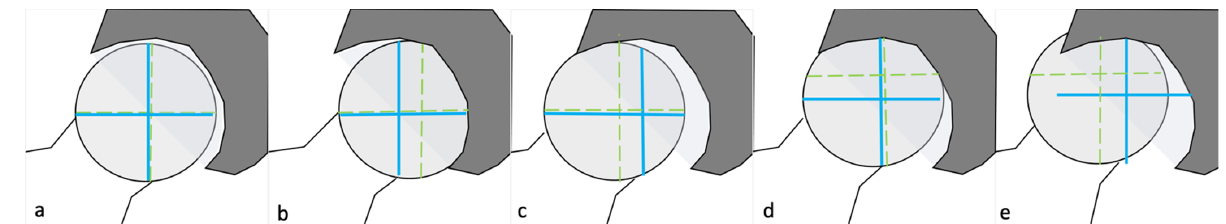
Figure 4. Hip deformities. Five types of hip deformities are shown, adapted from Kase et al. [11]. On each scheme, the femoral head is colored in grey, the acetabulum in dark grey, and the acetabular cavity in transparent grey. The blue lines correspond to the acetabular center and the green dotted line to the vertical and horizontal axis of the femoral head. In ( a ), a centered hip is shown as both axes are superimposed; in ( b ), a medialized (medialization of the vertical axis of the femoral head with respect to the acetabular one); in ( c ) a lateralized (lateralization of the vertical axis of the femoral head with respect to the acetabular one); in ( d ) a proximalized (cephalic displacement of the horizontal axis of the femoral head with respect to the acetabular one); and in ( e ) a proximo‐lateralized (cephalic displacement of the horizontal axis of the femoral head with respect to the acetabular one, and lateral displacement of the vertical axis of the femoral head with respect to the acetabular one). An arbitrary cut‐off of 3 mm was used by the authors to consider a displacement in each plane.